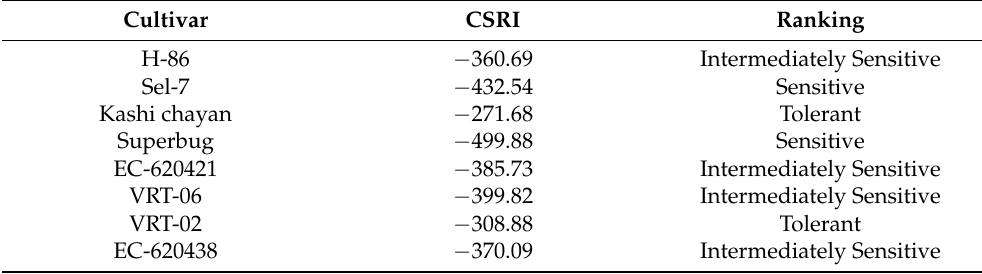
Table 2. Categorization of test tomato cultivars as tolerant, intermediately sensitive, and sensitive, based on CSRI (cumulative stress response index) values.